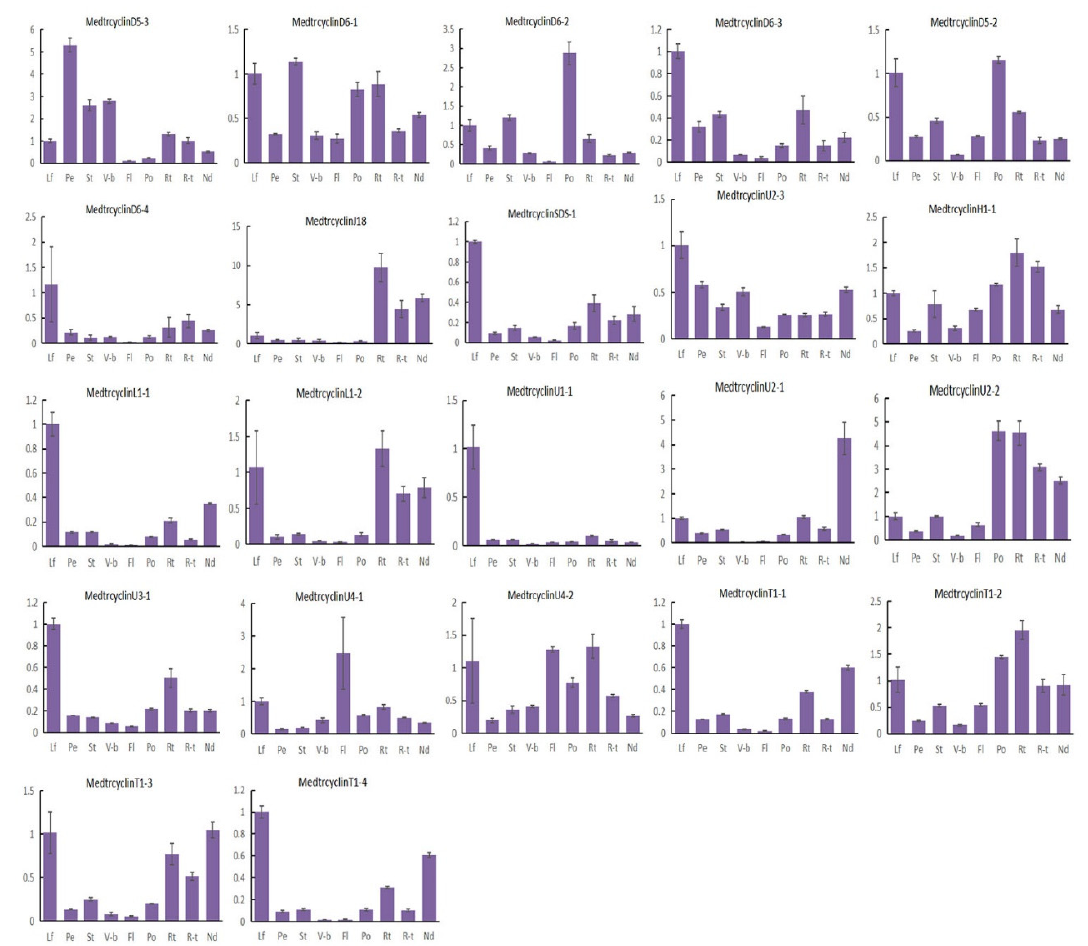
Figure 4. Expression levels of Mtcyclins in various tissues. Expression profiles of Mtcyclin genes were analyzed in nine different tissues: leaf (L), petiole (Pe), stem (St), vegetive bud (V-b), flower (Fl), pod (Po), root (Rt), root tip (R-t), and nodule (Nd). The data are from three independent biological replicates, and error bars indicate standard deviations.